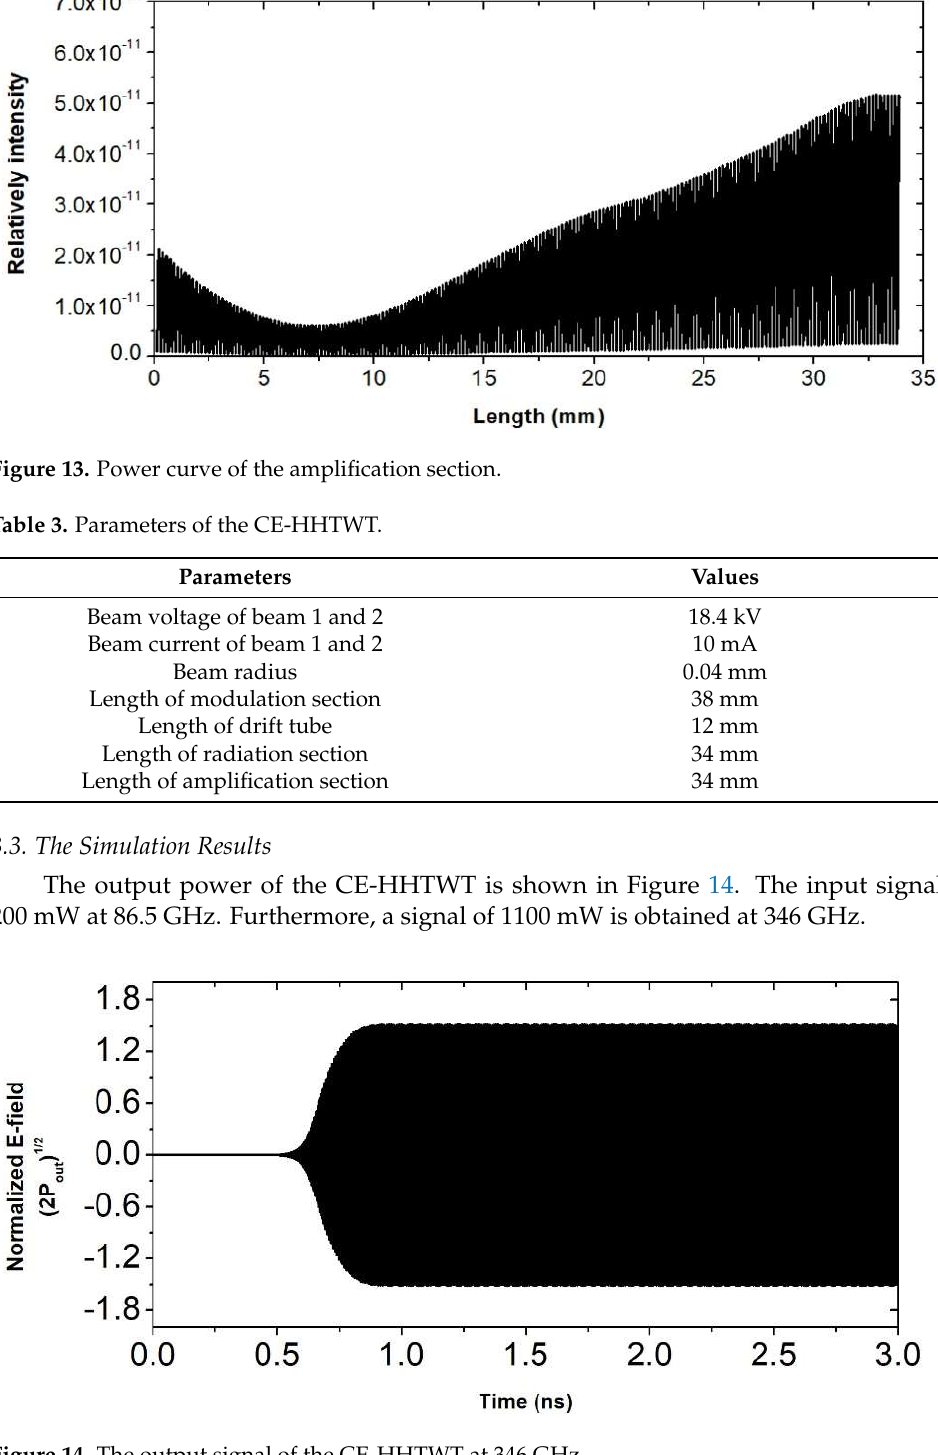
Figure 14. The output signal of the CE-HHTWT at 346 GHz. Figure 15 is the Fourier transform of signal at end of the amplification section. The spectrum of the output signal is concentrated at the frequency of 346 GHz.